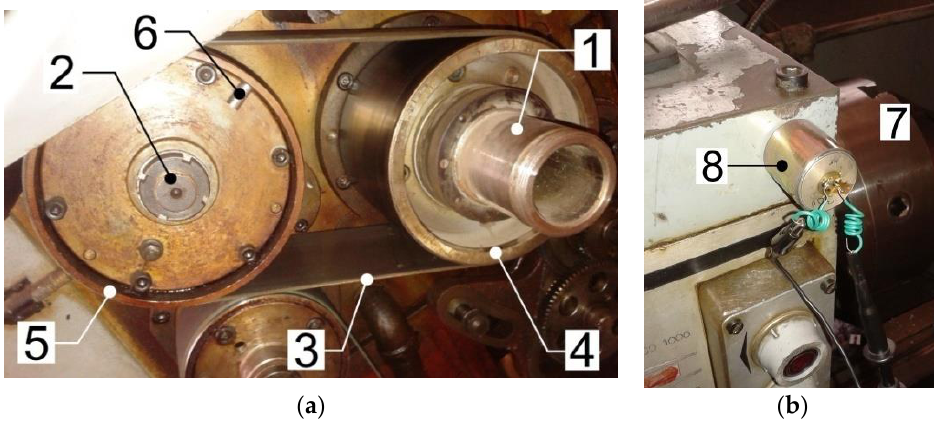
Figure 2. ( a ) A lateral view of the shafts involved in the beating phenomenon (with a flat belt transmission between the shafts); ( b ) A front view of the lathe headstock with the vibration